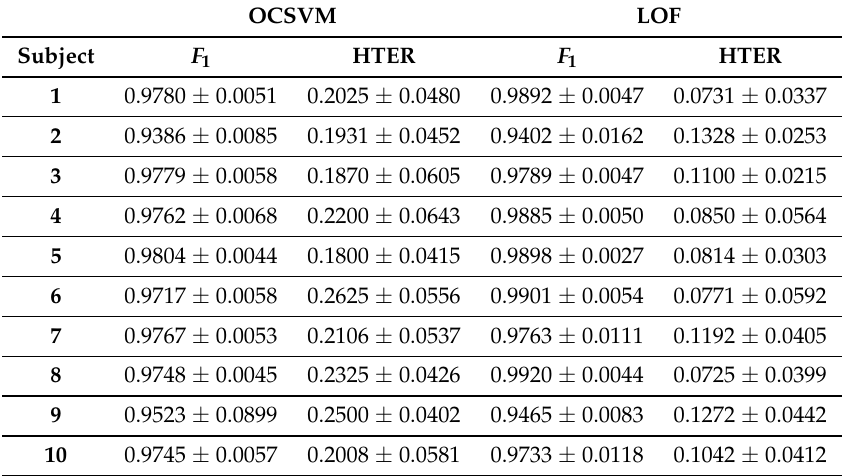
Table 2. Authentication test results of 10 subjects (Pattern